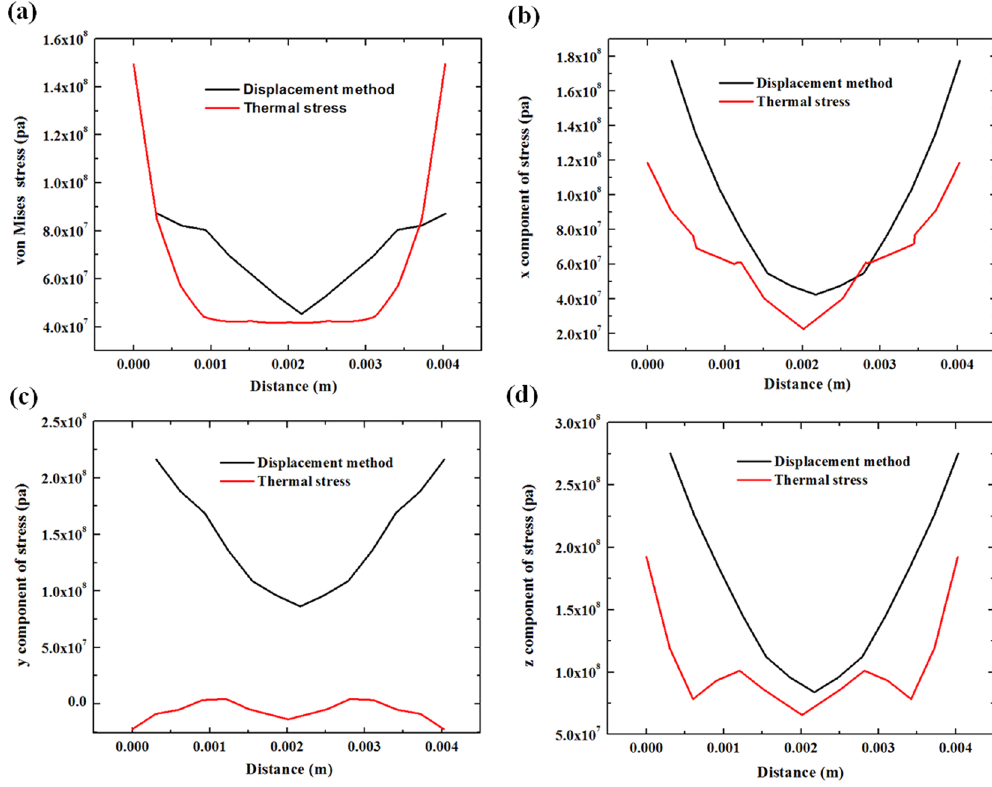
Figure 8. The stress distribution at the deposition/substrate interface in section B. ( a ) von Mises stress, ( b ) x component of stress, ( c ) y component of stress, ( d ) z component of